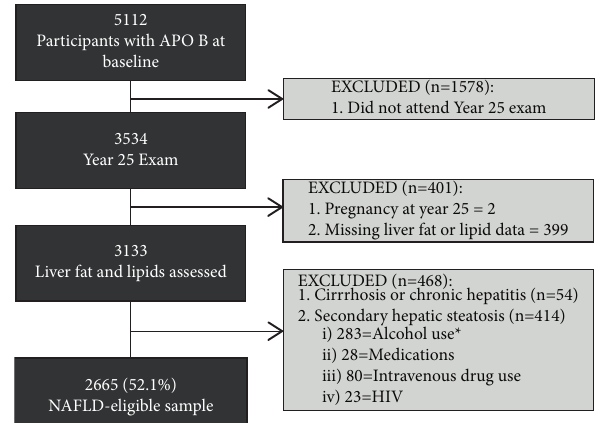
Figure 1: Sample population inclusion. ∗ Alcohol use was defined as > 7 drinks/week for women and > 14 drinks/week for men. †Medications � valproic acid, methotrexate, tamoxifen, and